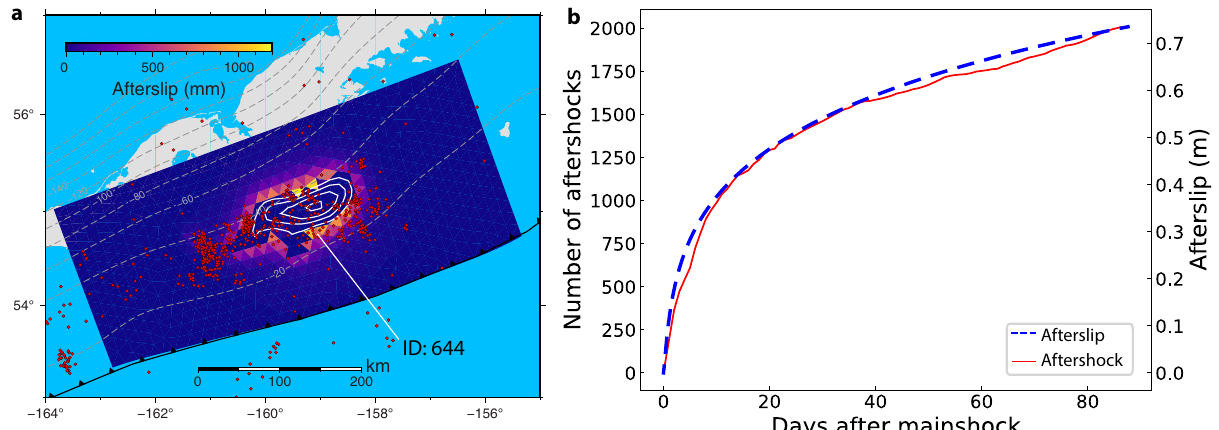
Fig. 6 Spatiotemporal correlation between afterslip and aftershocks. a Spatial distribution of afterslip and aftershocks in fi rst 87 days after the 2020 Simeonof earthquake (red dots). b Comparison of the temporal decay of stress-driven afterslip with that of the aftershock activity. Red line shows the cumulative number of aftershocks near the slab interface near the coseismic rupture zone (Fig. 2). Dashed blue line represents postseismic afterslip evolution in the fi rst 87-day period on a selected triangular element with index number 644 labeled in ( a